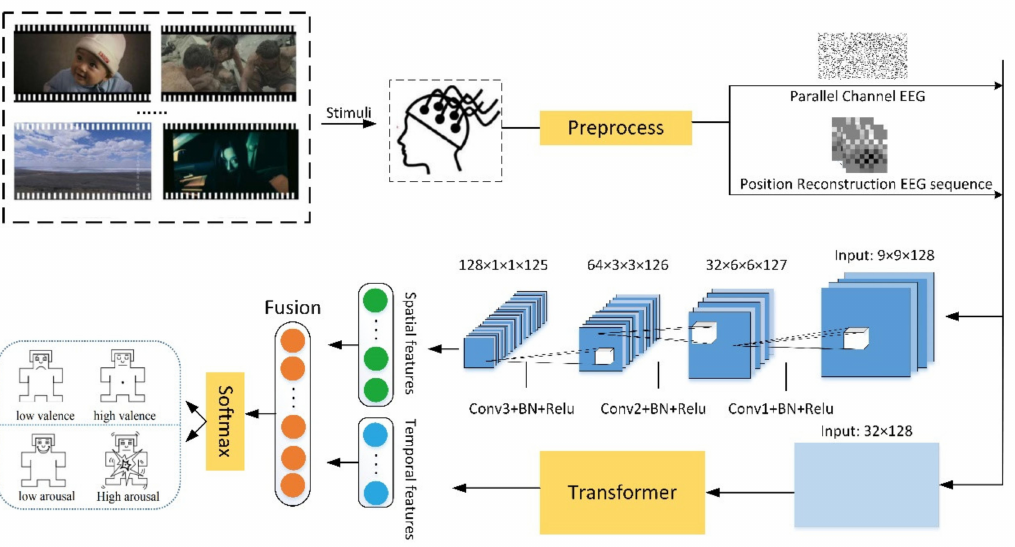
Figure 6. The overall framework of TSFFN. EEG data are simultaneously recorded while subjects watch emotional film clips as stimuli. The spatial and temporal features of EEG are extracted by a parallel model. The emotion predictions are given with the model based on the fused